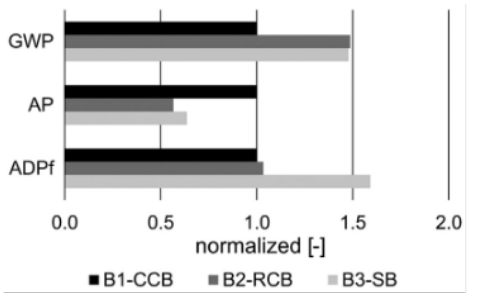
Figure 9. Comparison of impact indicators of vari- ous pedestrian bridge types (normalized values), ex- tracted from [5].